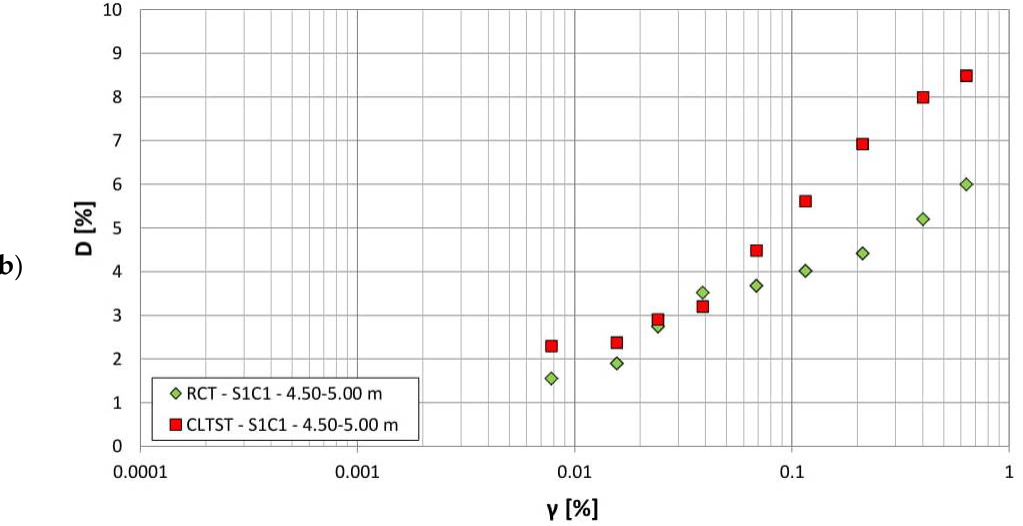
Figure 8. ( a ) G [MPa] versus γ [%] curves. ( b ) D [%] versus γ [%] curves (for the S1C1 soil sample).